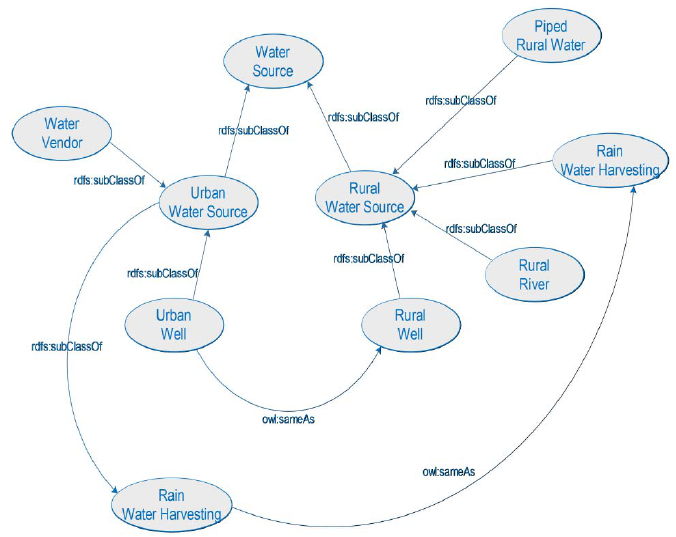
Figure 7. An example of Cross ‐ sectional concepts for SEMA’s Water Source Reports.